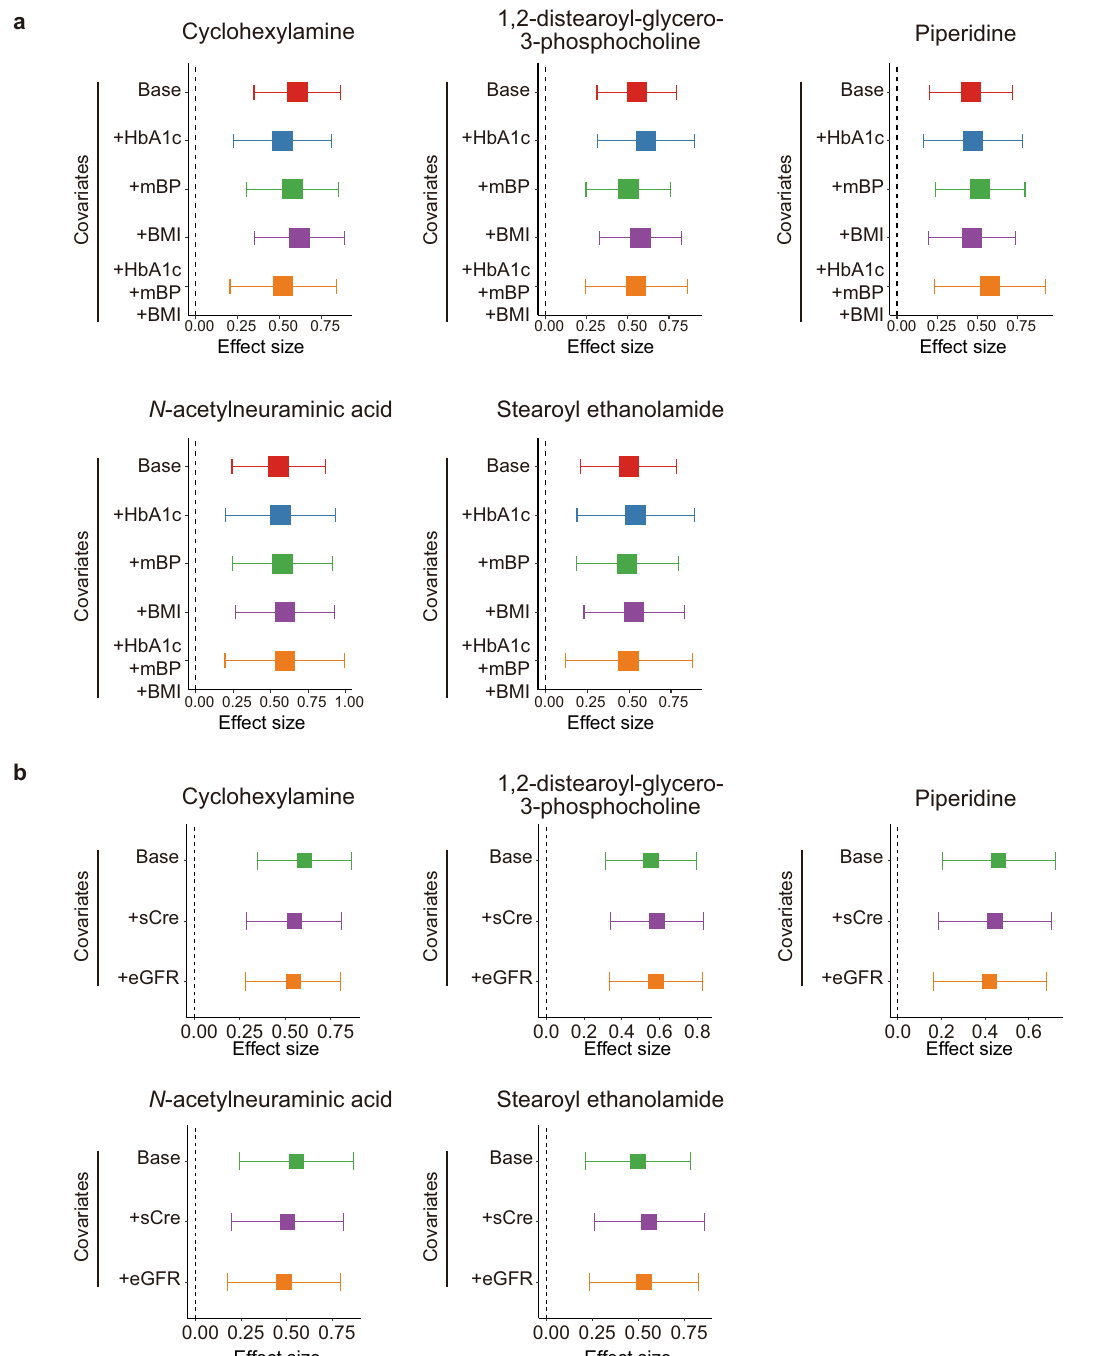
Fig. 2 Forest plots from the results of the sub-analyses for the metabolites with signi fi cant association to the complications of T2D. The effect sizes of the sub-analyses for the metabolites with signi fi cant association to DR + DKD. The sub-analyses are performed for the a risk factors of the complications and b the markers of the renal function by logistic regression. The boxes indicate the point estimates, and the error bars indicate the 95% con fi dence interval. Number of the samples used for sub-analyses are following; Base, N DR + DKD = 141, N control = 159; + HbA1c, N DR + DKD = 109, N control = 112; + mBP, N DR + DKD = 131, N = 132; + BMI, N = 135, N = 147; + HbA1c + mBP + BMI, N = 98, N = 93; + sCre and + eGFR, N = 139, N = 157. control DR + DKD control DR + DKD control DR + DKD control BMI, body mass index; DKD, diabetic kidney disease; DR diabetic retinopathy; eGFR, estimated glomerular fi ltration rate; HbA1c, hemoglobin A1c; mBP, mean blood pressure; sCre, serum creatinine; T2D, type 2